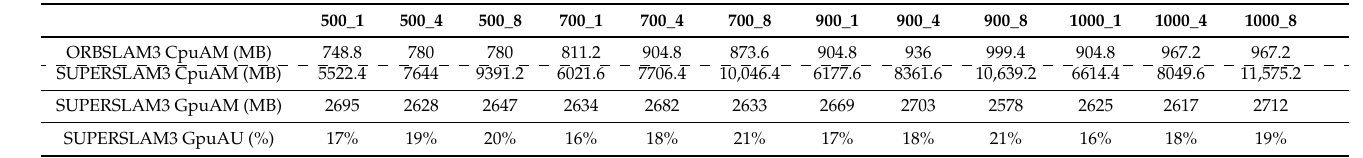
Table 5. Analysis of the CPU and GPU performance statistics in relation to the parameter set used. AM: Average Memory, AU: Average Utilization. In the table’s top header the parameters set are represented in the form ‘ nFeatures_nLevels